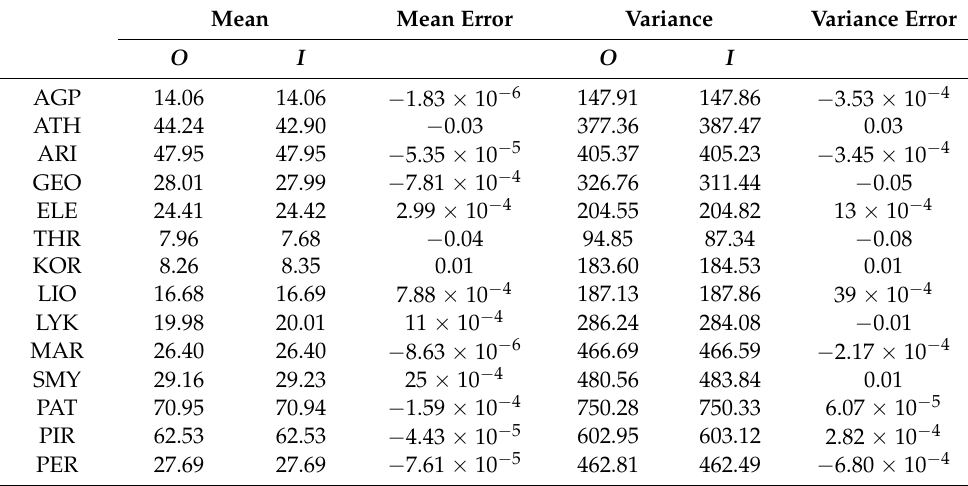
Table 5. Mean and variance values results, for the original ( O ) and the interpolated ( I ) datasets, along with the corresponding error, per monitoring station for NO 2 .